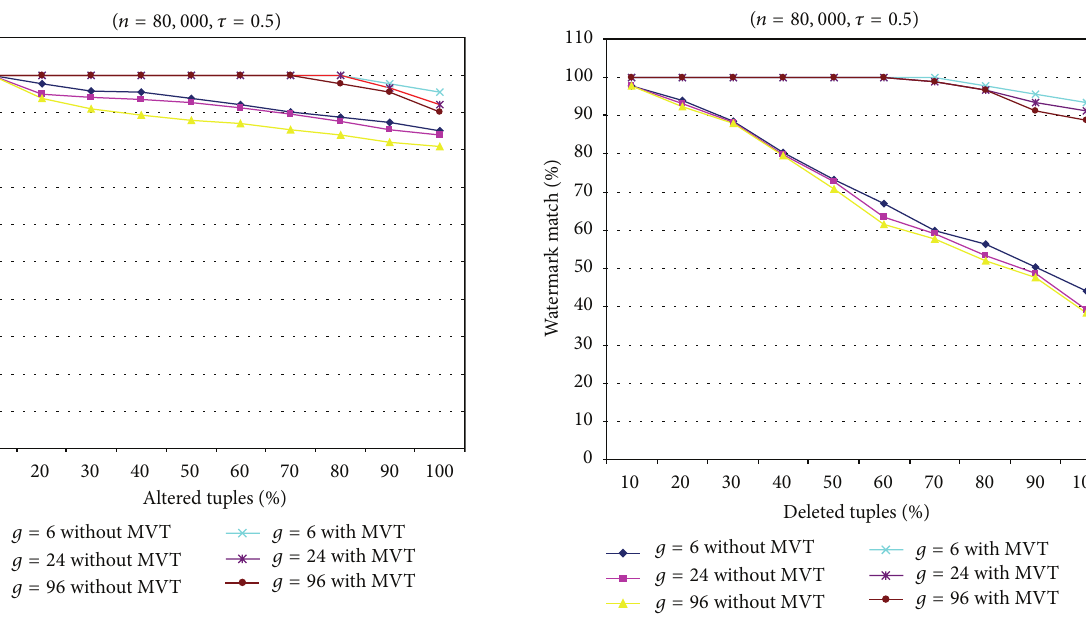
Figure 5: Resilience to the deletion attack.